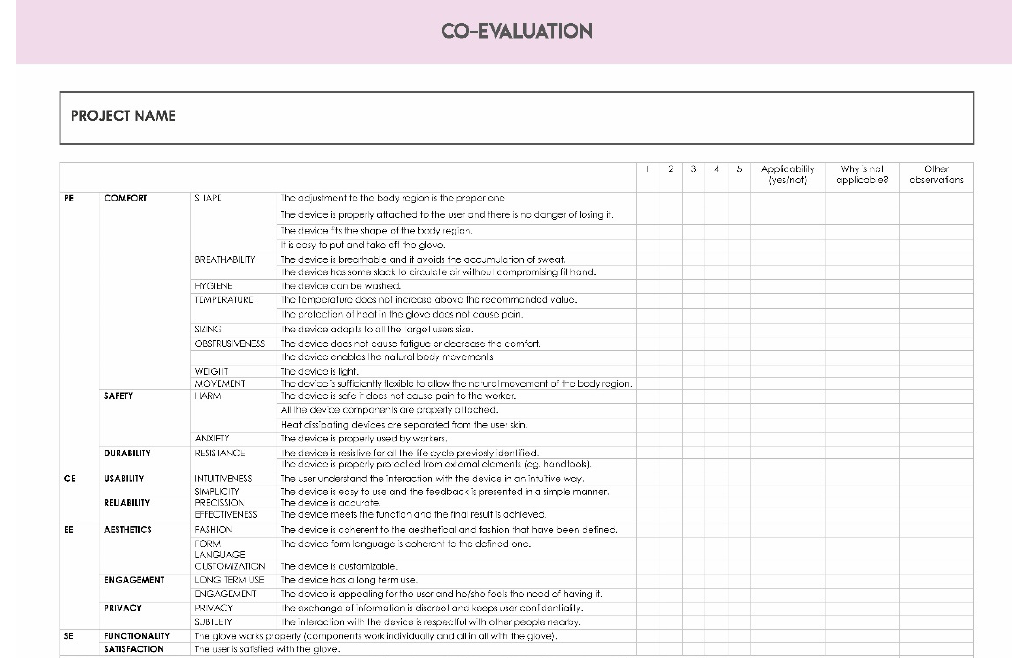
Figure 6. Content and structure of the Checkpoint template.